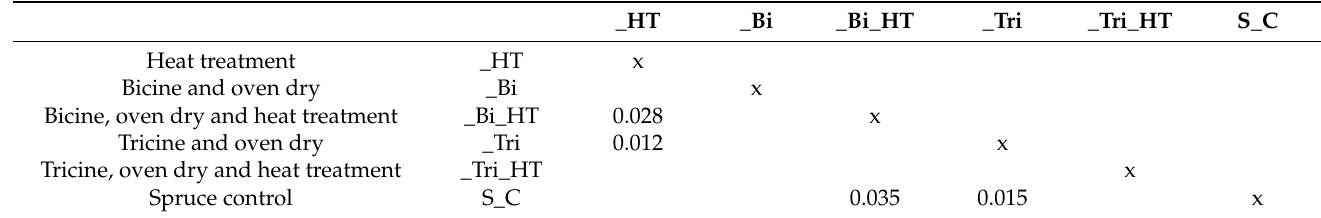
Figure 9. Overview of termite tests with various treatments. ( a ) Survival rates of Reticulitermes grassei Clément and ( b ) mass losses of samples following a modified EN117 experiment [42]. Tukey analysis groups shown above each bar graph. Table 11. Significant results ( p < 0.05) of the Tukey’s honestly significant difference test (HSD) for termite survival in untreated and treated spruce (non-significant p values are not shown in this table).